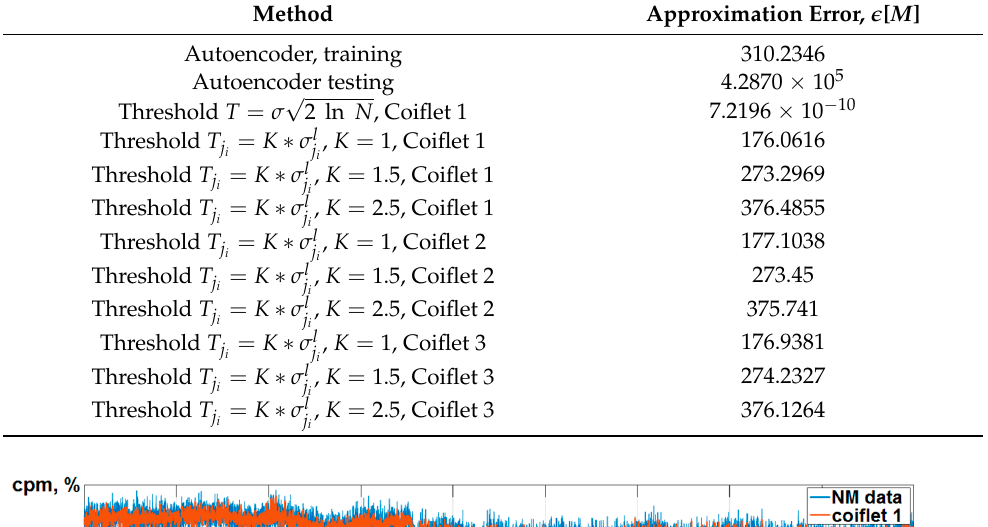
Table 3. Estimation of the approximation error.